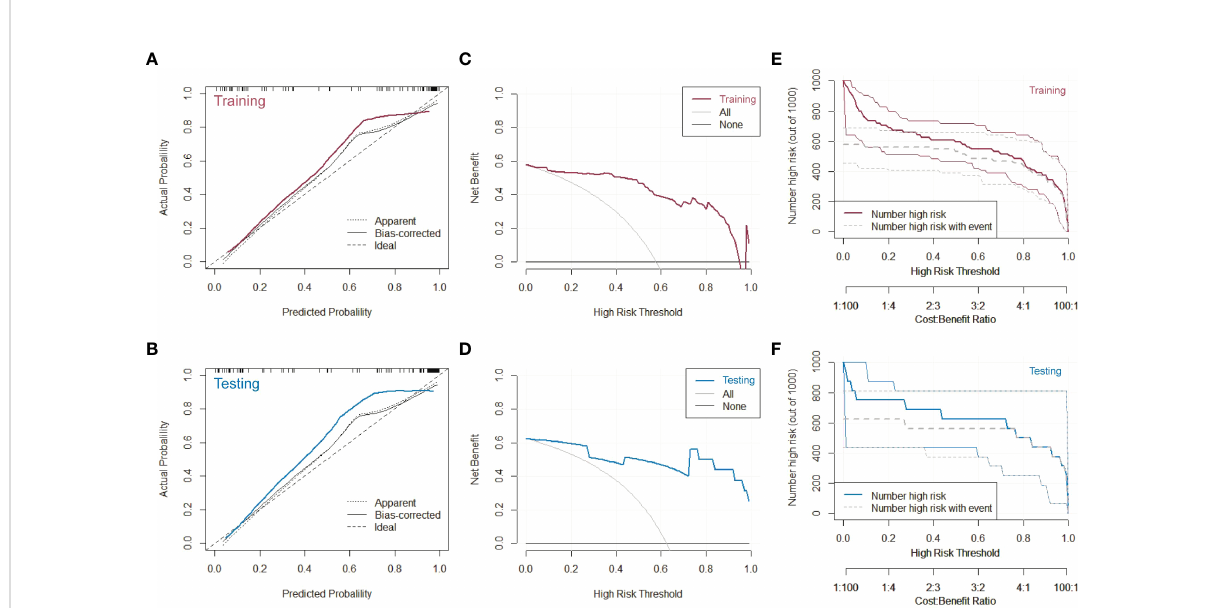
FIGURE 5 Characterizations of the PET/MRI + CT + Clinical prediction model. (A) Calibration curve, (C) decision curve and (E) clinical impact curve of the model on the training dataset. (B) Calibration curve, (D) decision curve and (F) clinical impact curve of the model on the testing